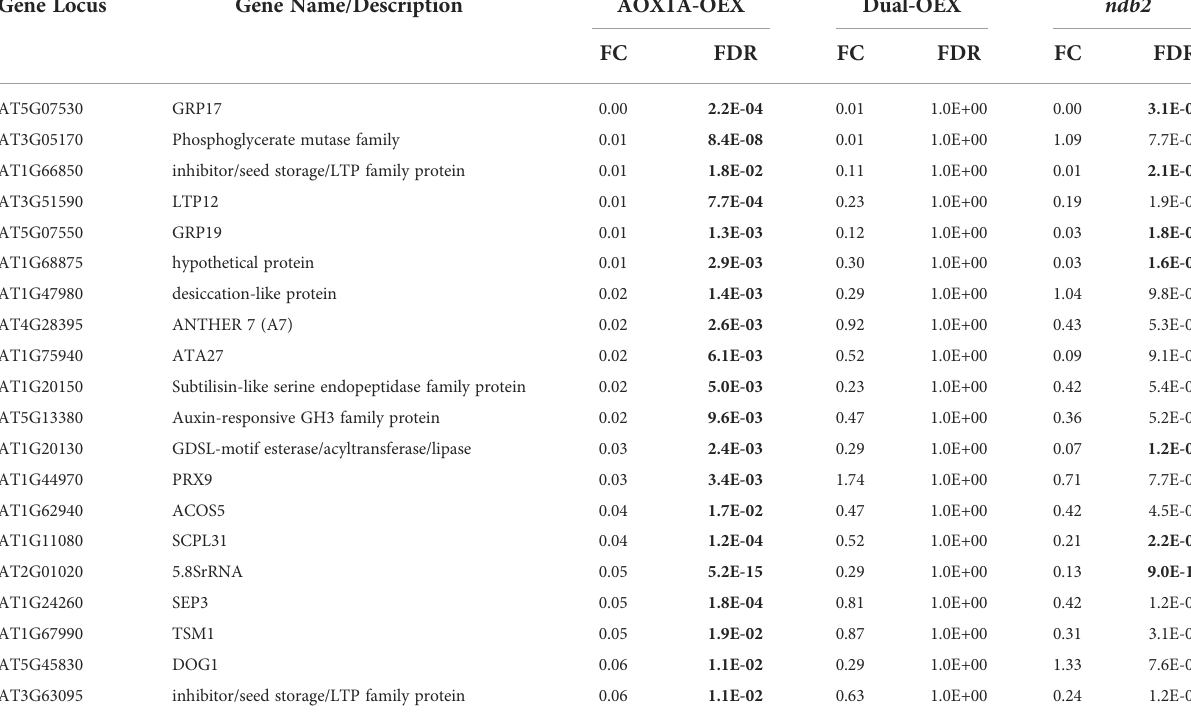
TABLE 2 Top 20 down-regulated DEGs for AOX1A overexpression line relative to wild type. Gene Locus Gene Name/Description